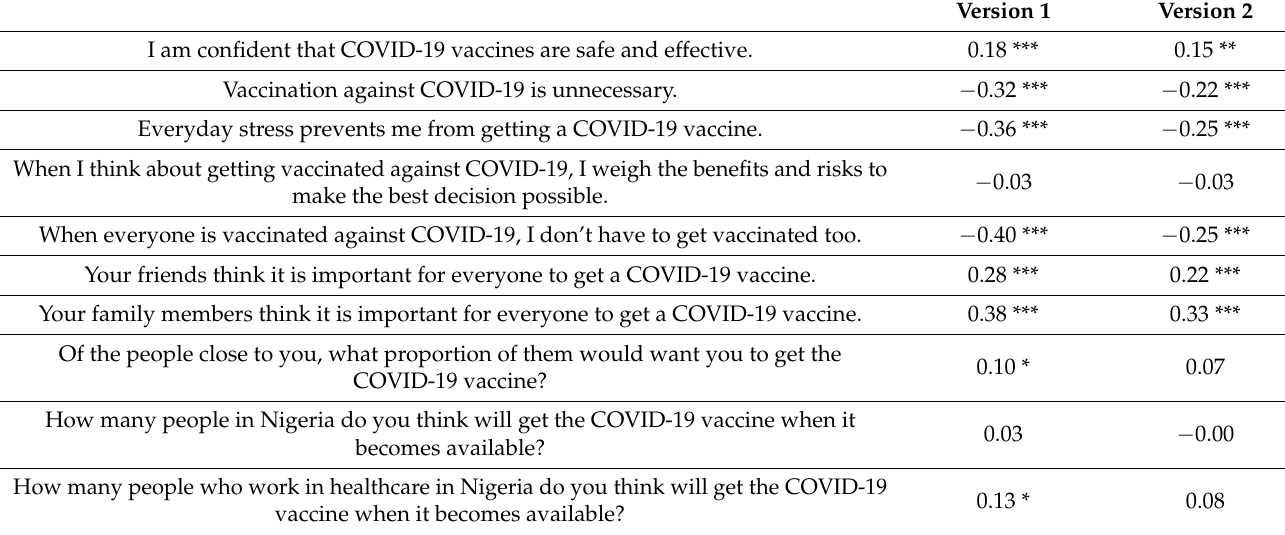
Table 5. Correlations between the ability indices and indicators of the five Cs and social norms in the holdout sample ( n =